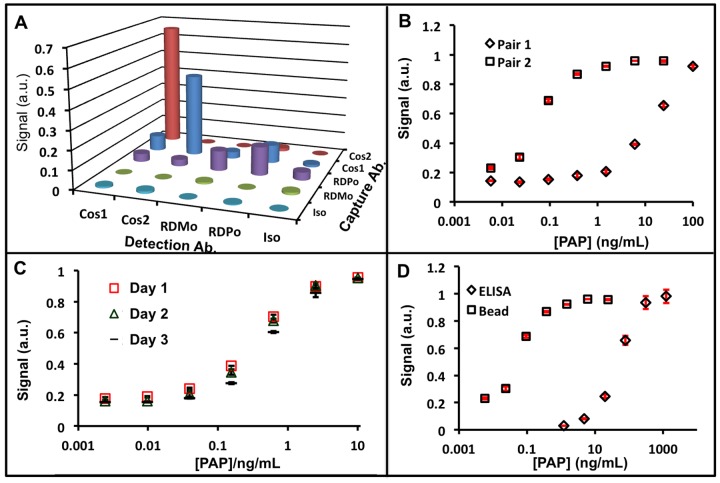
Assay Construction.
A) Optimal antibody pairs were identified with a “checkerboard” assay that evaluated different antibody pairs as well as isotype controls. Metric plotted here is signal difference between the negative control and 1 ng/mL recombinant PAP. The different antibodies are defined in the Materials and Methods section. B) A full calibration curve illustrates the different sensitivities of different antibody pairs for PAP. Pair 1: Cos2 c.Ab.; Cos1 d.Ab. Pair 2: RDPo c.Ab.; RDMo. d.Ab. The red error bars represent the standard deviation of at least three replicate measurements. C) Reproducibility from day to day is <8%. D) The piezo-based approach shows 3 log orders improvement in analytical sensitivity versus direct ELISA when identical antibody pairs are used (Cos1/Cos2).